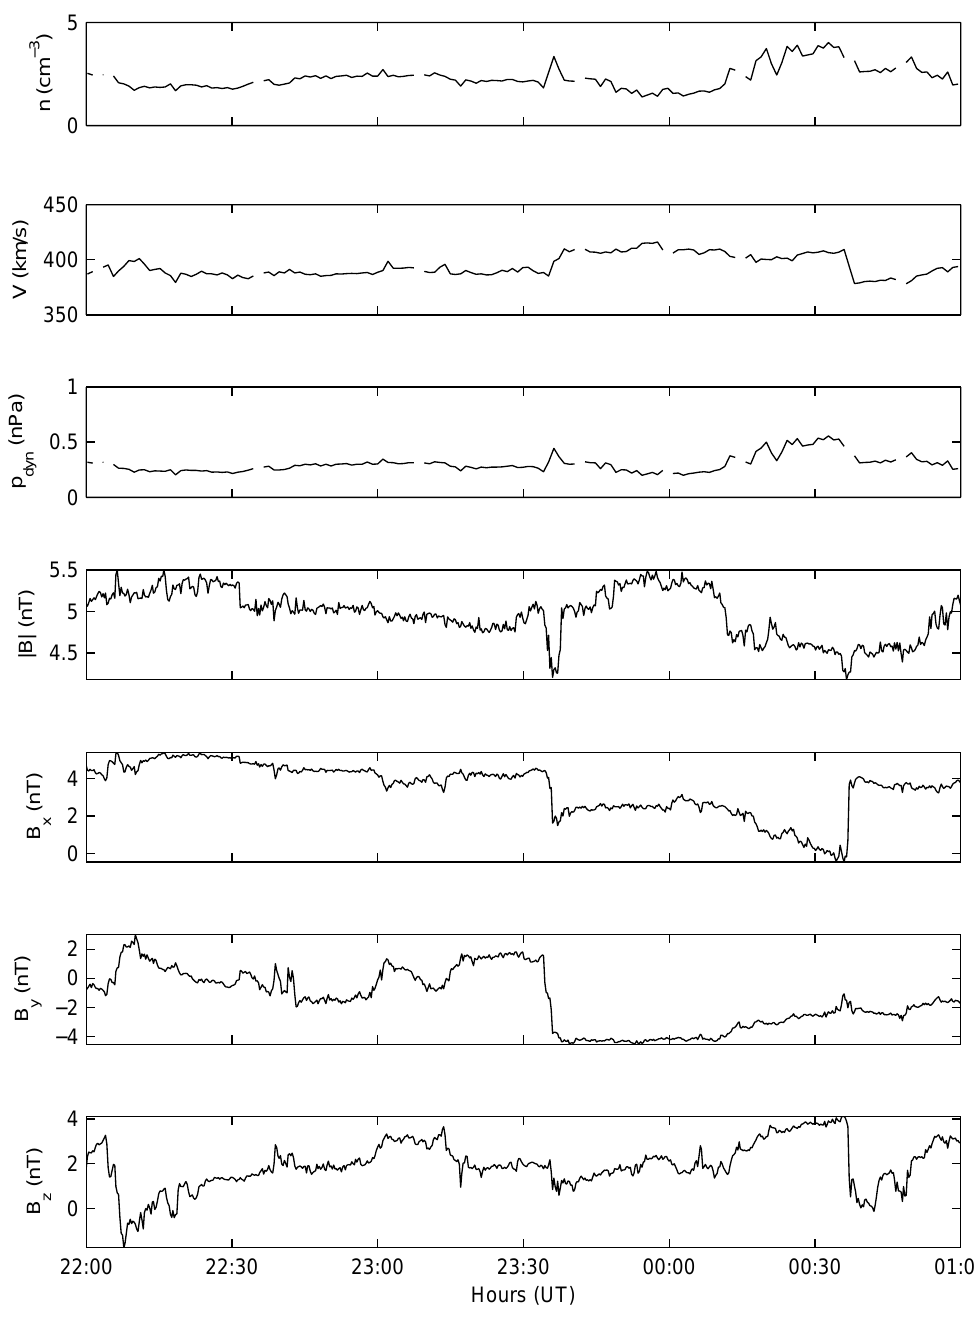
Fig. 2. Solar wind parameters measured by the ACE spacecraft.